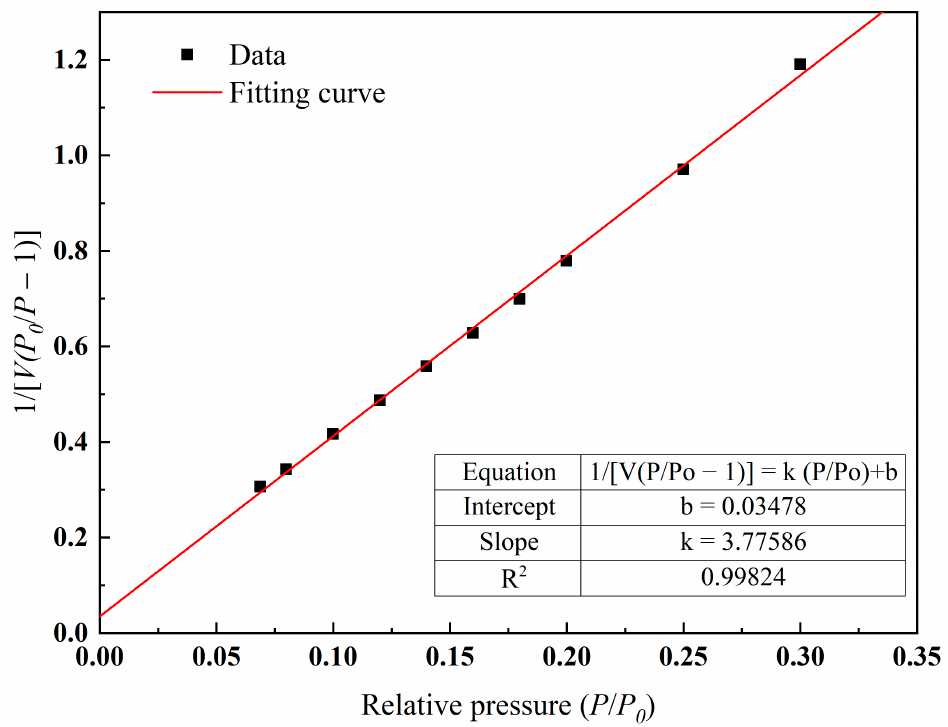
Figure 6. Calculation and analysis graph of specific surface area.